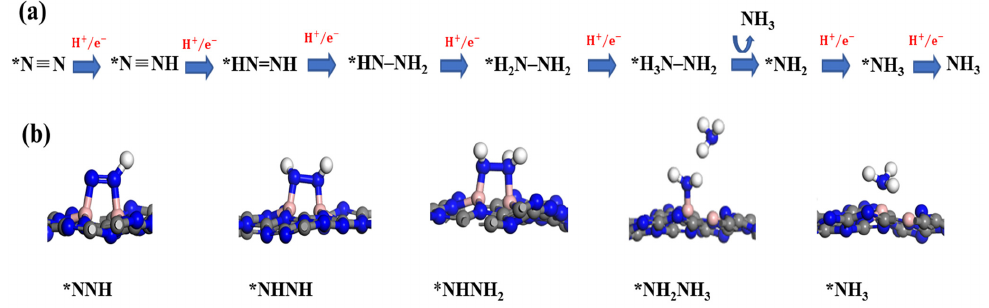
Figure 5. ( a ) The enzymatic pathway of NRR occuring on the catalyst; ( b ) Optimized geometric structures of various reaction intermediates of NRR on B2@C 3 N 4 .